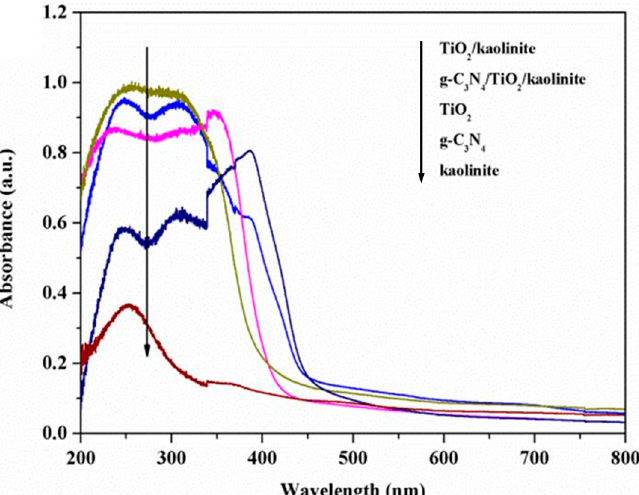
Figure 14. UV-Vis DRS of TiO 2 /kaolinite and g-C 3 N 4 /TiO 2 /kaolinite composite systems, and of the single components TiO 2 , g-C 3 N 4 , and kaolinite. Ordering of the spectra as indcated by black vertical arrow and the adjacent legend. Adapted with permission from ref. [237]. Copyright 2017 Elsevier.